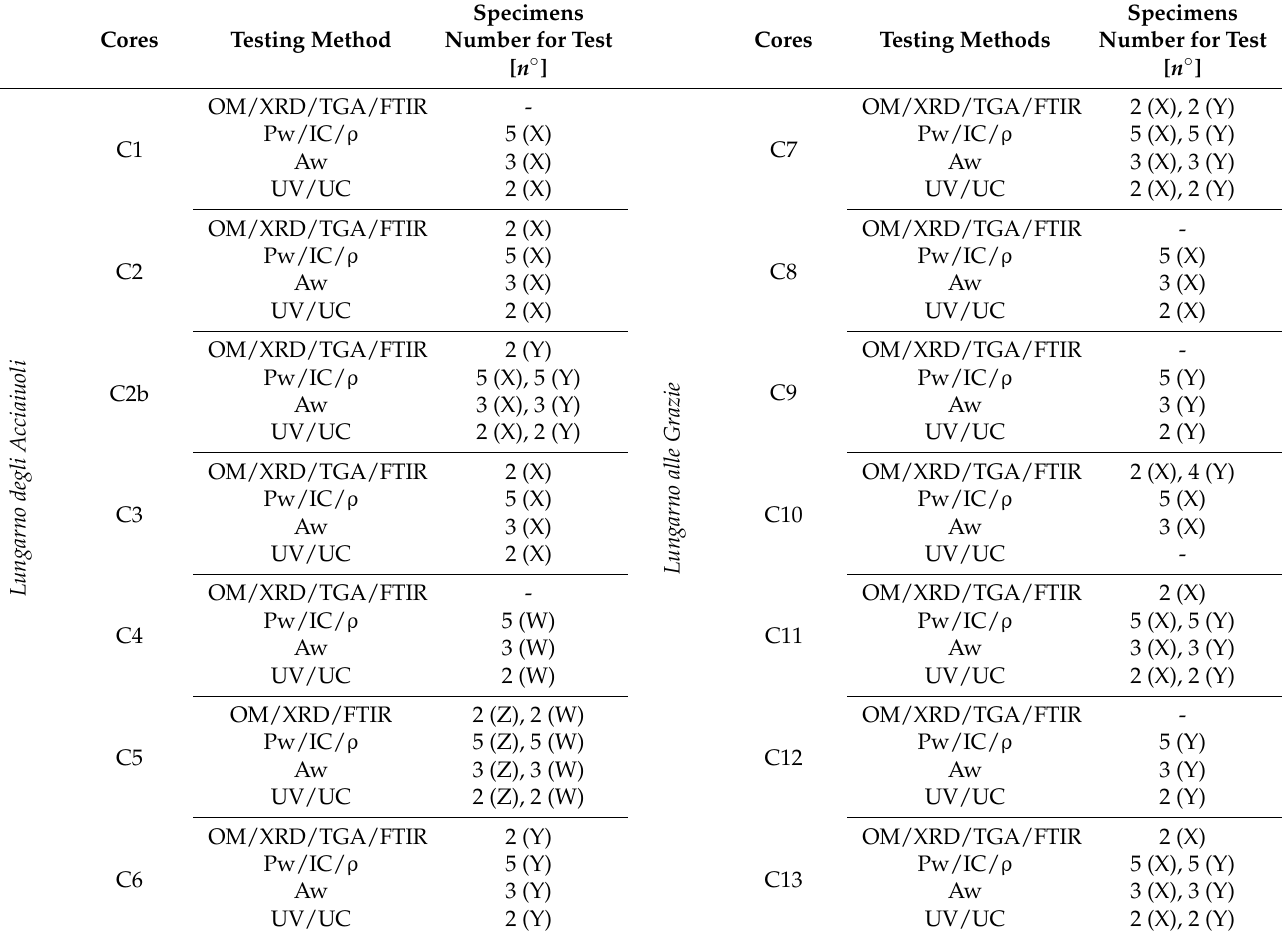
Table 2. Selected samples for the multi-analytical